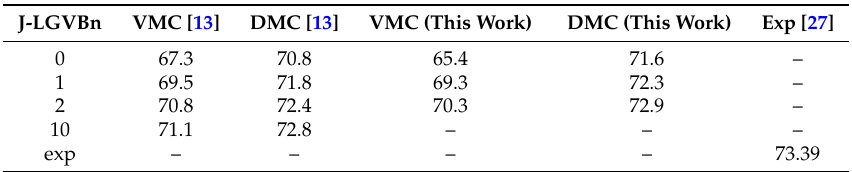
Table 2. Fragmentation energy (kcal/mol) of hydrazine computed at various level of calculation and comparison with experimental data. Statistical error is about 0.1 kcal/mol. The experimental (exp) reference is active thermochemical tables (ATcT) [27] data corrected for zero-point energy, spin-orbit interaction, and Born–Oppenheimer approximation